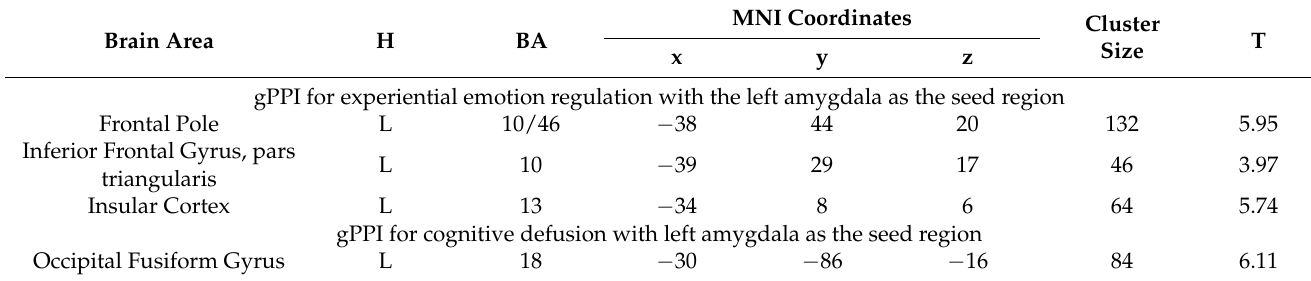
Table 5. Connectivity results from the generalized psychophysiological interactions (gPPI) analysis.